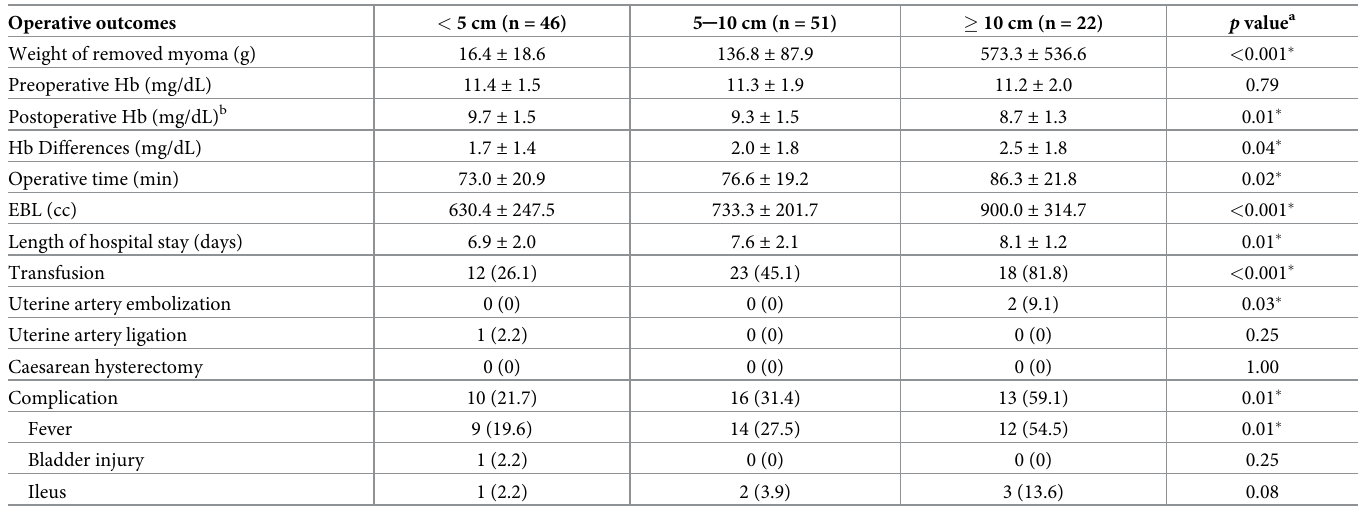
Table 5. Operative outcomes according to the myoma size in CM group (n = 119).